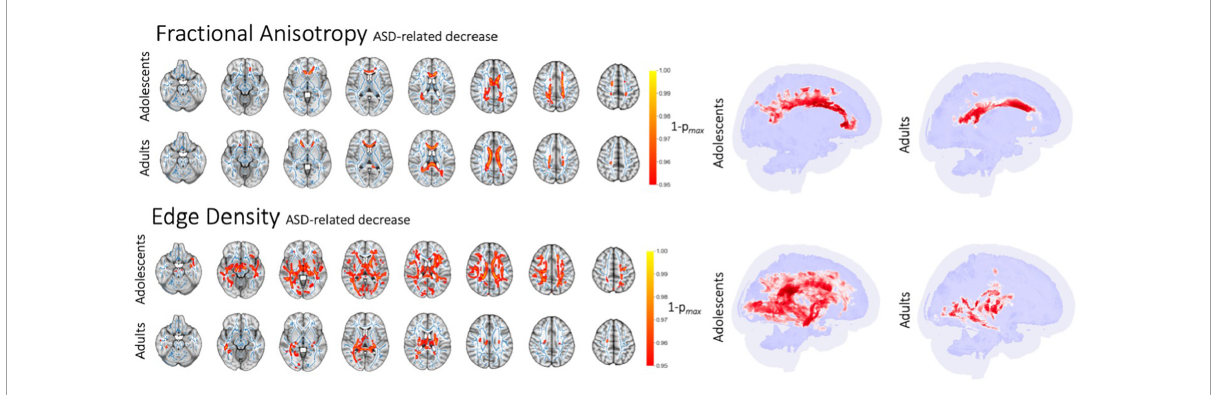
FIGURE3 ASD-related decrease in FA and ED in voxel-wise analysis after correction for age. Figure shows white matter tracts with significant difference in red ( p < 0.05) overlaid on the mean FA skeleton resulting from TBSS